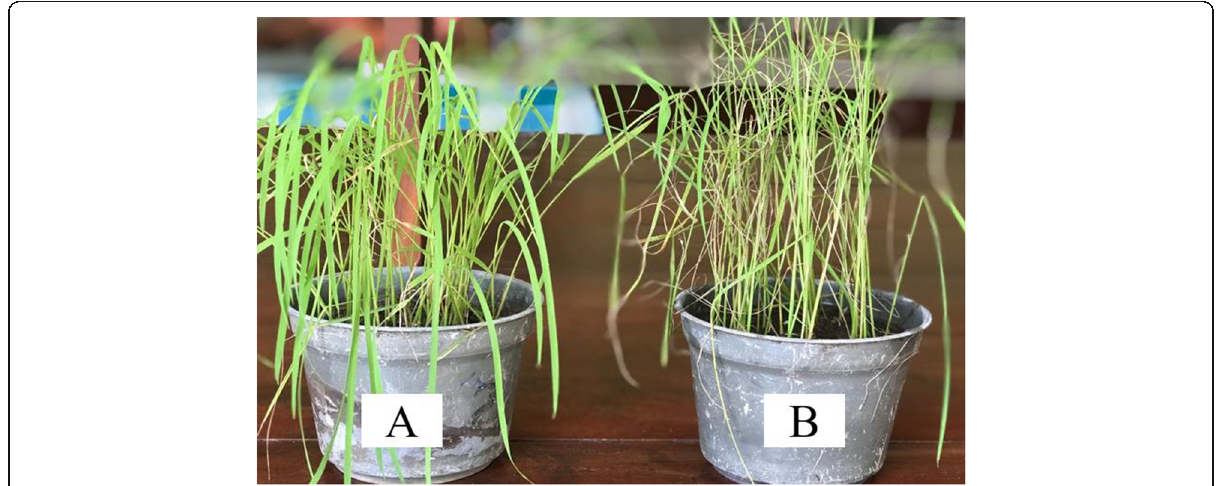
Fig. 4 Seedlings of rice cultivars after 14 days of inoculation of M. oryzae conidia. Bg 360 ( A ) and Attakari ( B ) recorded severity scales 1 and 6